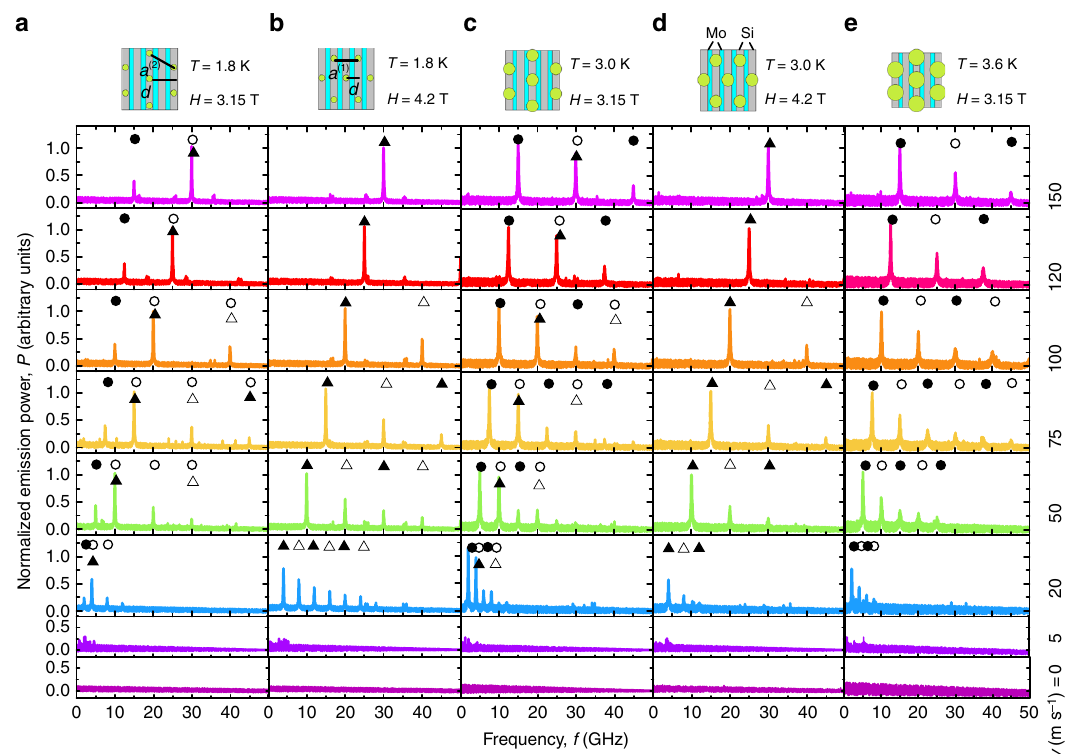
Fig. 2 Microwave emission from Abrikosov vortices in the Mo/Si superlattice. a – e Emission spectra for a series of vortex velocities v , as indicated, at H = 3.15 and 4.2 T and T = 1.8, 3.0, and 3.6 K. The symbols above the emission peaks indicate the frequencies f m = mf 0 , which are harmonically related to the washboard frequency f ð 1 Þ associated with the 50 Å-periodic layered structure (triangles) and f ð 2 Þ related to the 100 Å-spaced vortex rows in the direction of 0 0 their motion (circles). The odd and even harmonics are indicated by solid and open symbols, respectively. The vortex lattice con fi gurations, which are ffiffiffi p ffiffiffi p ¼ 3 : 15 T with a ð 2 Þ ¼ 2 d ð 2 Þ = ¼ 4 s = ¼ 4 : 2 T with a (1) = 2 d (1) = 2 s , are shown in the commensurate with the Mo/Si multilayer period at H ð 2 Þ N ¼ 3 3 and H ð 1 Þ N ¼ 2 1 scaled coordinate system ( γ a , c ) above the panels. In the absence of transport current, vortices are centered in regions of reduced order parameter, the Si layers. The size of the circles denoting the vortex cores (not to scale) re fl ects their relation to the Si layer thickness d Si and the multilayer period